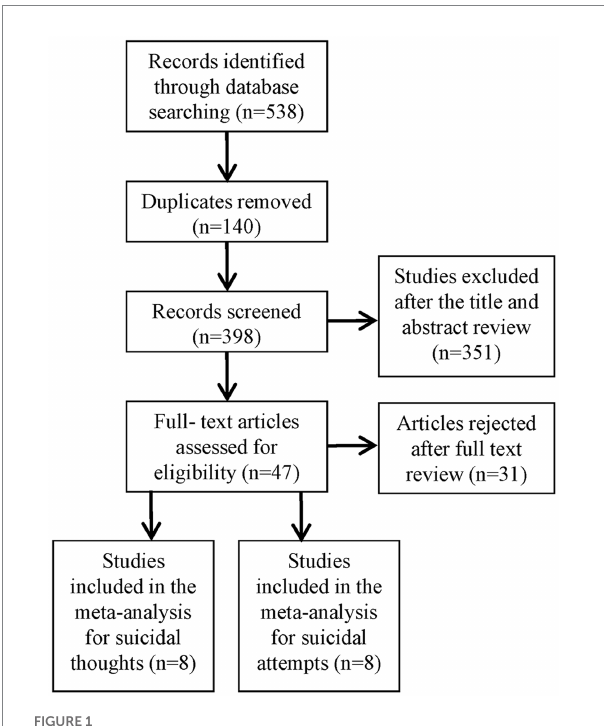
FIGURE 1 Flowchart of identification and selection of studies included in the